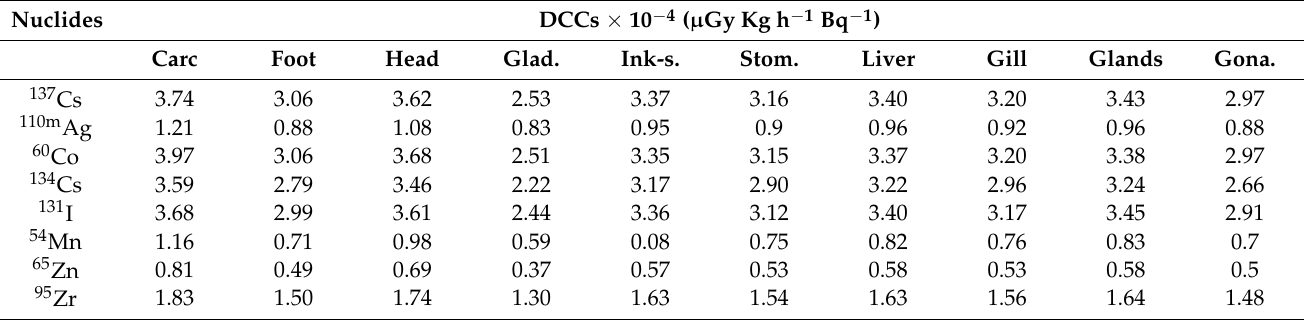
Table 6. Internal dose conversion coefficient of squid